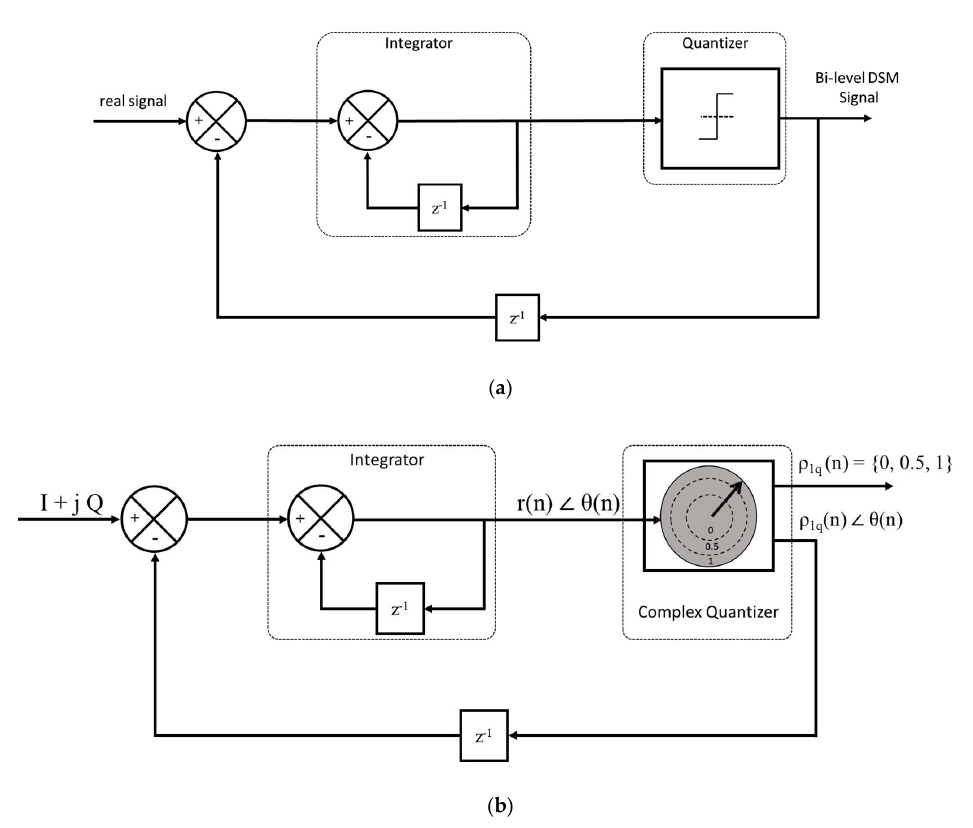
Figure 1. ( a ) Delta Sigma modulator blocks; ( b ) CxDSM block diagram.